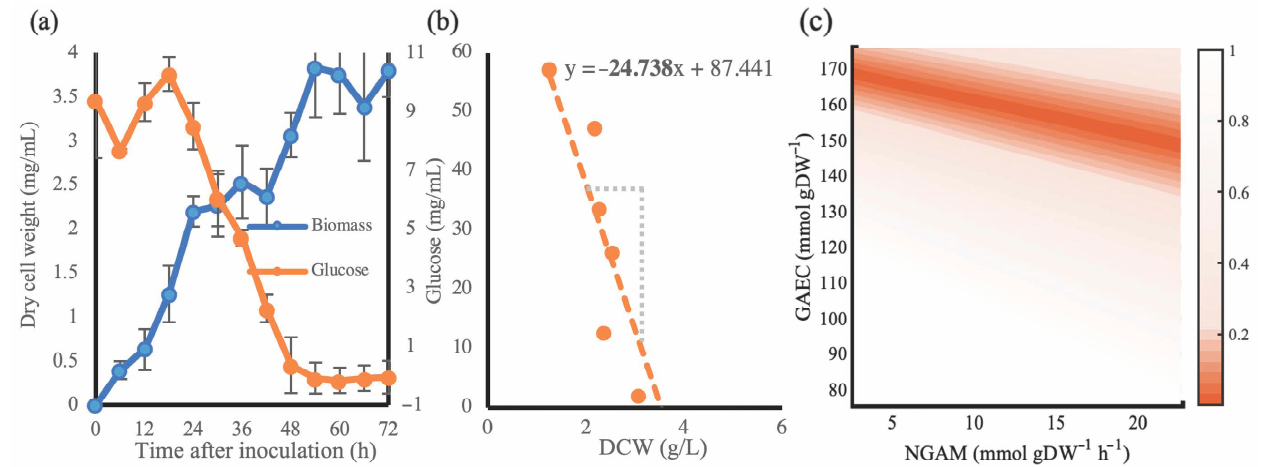
Figure 2. Cultivation data of S. albus J1074 grown on NL333 medium. ( a ) concentrations of dry cell weight of biomass (blue) and glucose (orange) in media sampled every 6 h over 72 h. ( b ) a plot of the recorded glucose levels (in mmol/L) and the corresponding biomass (in g/L) provides an estimate of the biomass yield. ( c ) comparison of deviations of predicted growth rates relative to the expected value of 0.04 h − 1 across a combination of tested NGAM and GAEC values. Deviations within 100% of the expected value are shown in